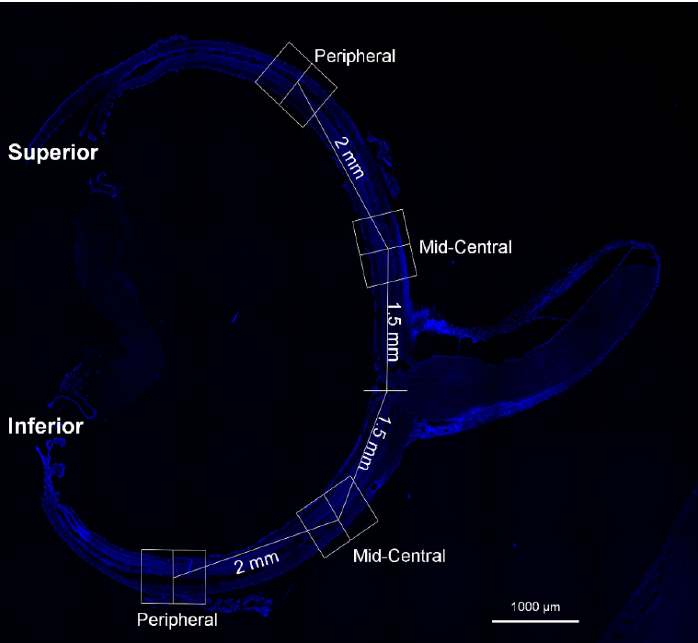
Figure 2. Representative posterior eyecup image stained with DAPI for analysis. Each eyecup was split into 2 mid-central (1.5 mm from the optic nerve) and 2 peripheral regions (3.5 mm from the optic nerve) for image